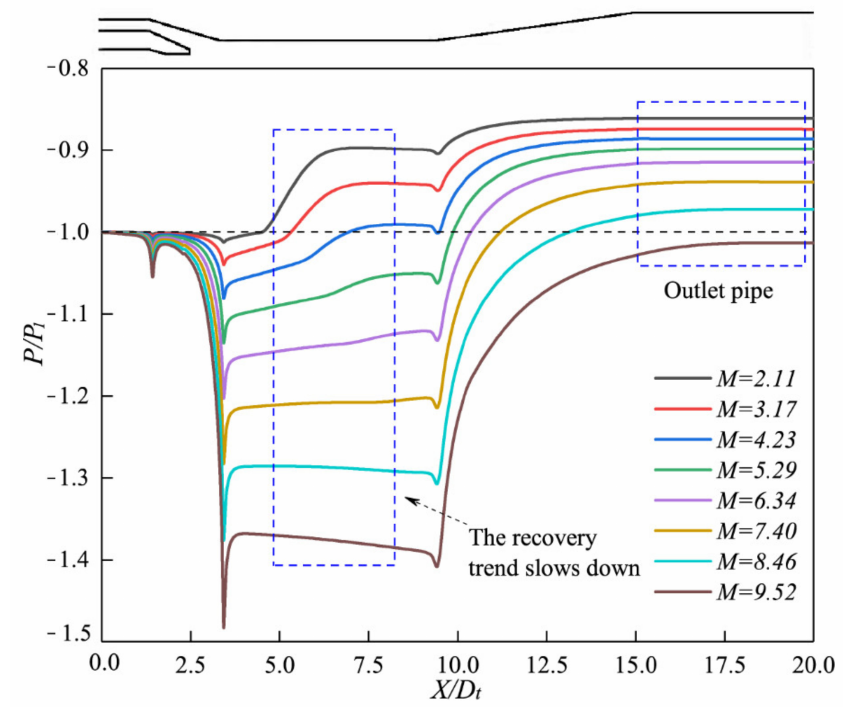
Figure 9. Wall pressure distribution of slurry from nozzle inlet to exit ( M = 2.11, 3.17, 4.23, 5.29, 6.34, 7.40, 8.46,